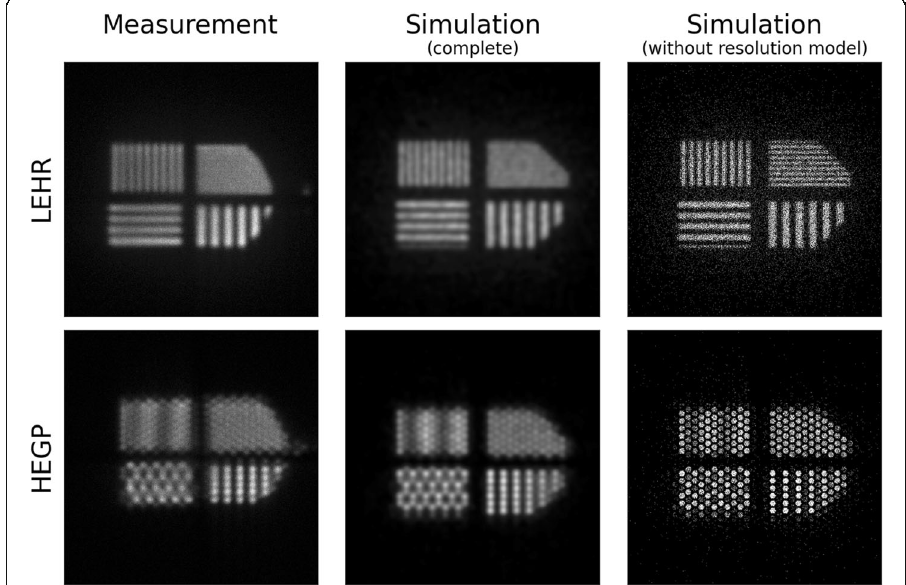
Fig. 6 Images of bar phantom. Measured and simulated images in planar setup for two collimators: top: low-energy, high-resolution collimator; bottom: high-energy, general-purpose collimator. Simulated images are shown before (right column) and after (central column) the spatial resolution model has been applied